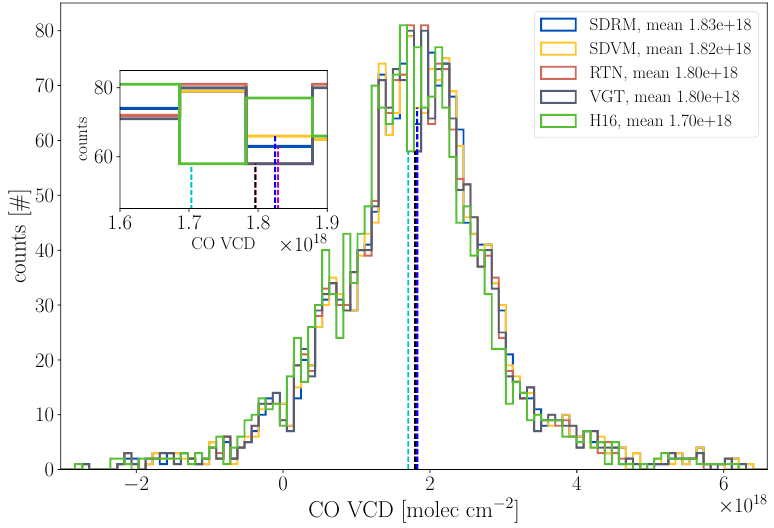
Figure 4. The CO total columns for different line shapes with SEOM input compared to HITRAN in orbit 8663. It shows that SEOM-based retrievals cause larger columns on average (dashed vertical